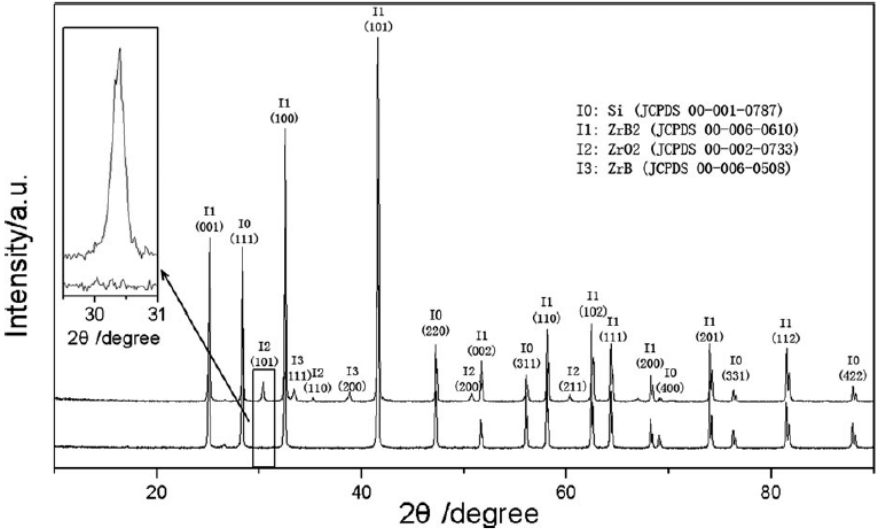
Figure 5. XRD patterns of samples mixed with the guide Si plate [65].